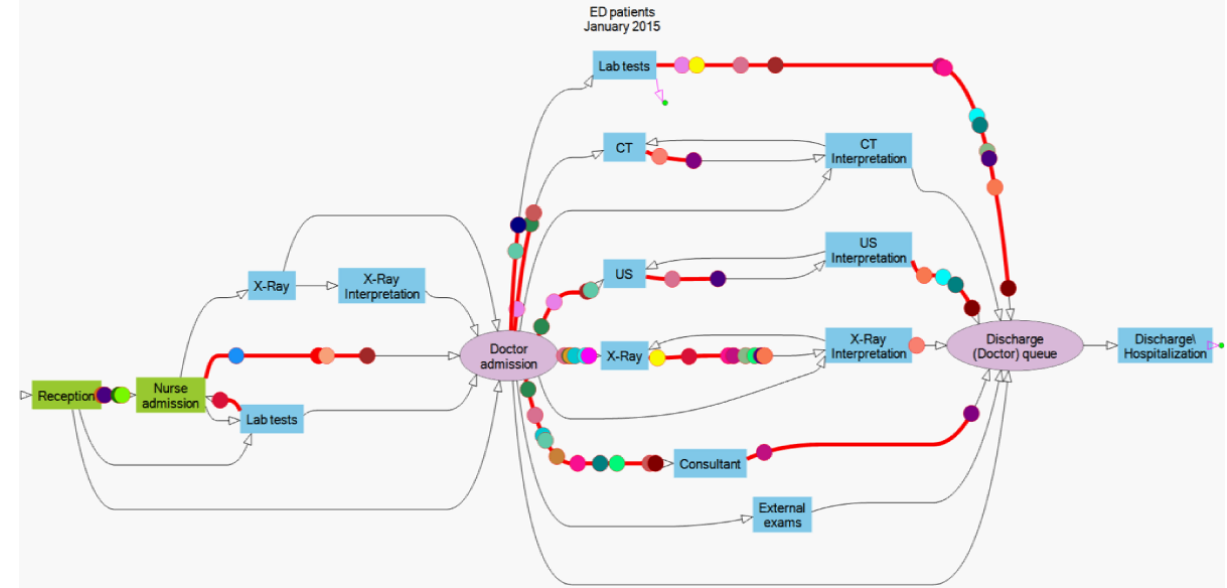
Figure 3. Process chart of all possible emergency department patient